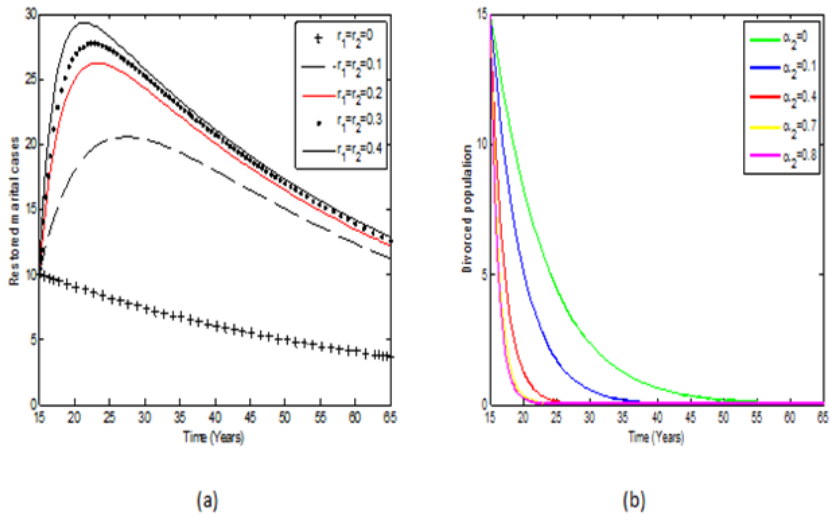
Figure 3. Impact of (a) reconciliation on Restored marital cases and (b) rate of remarriage on Divorced dynamics using parameter values in Table 2.